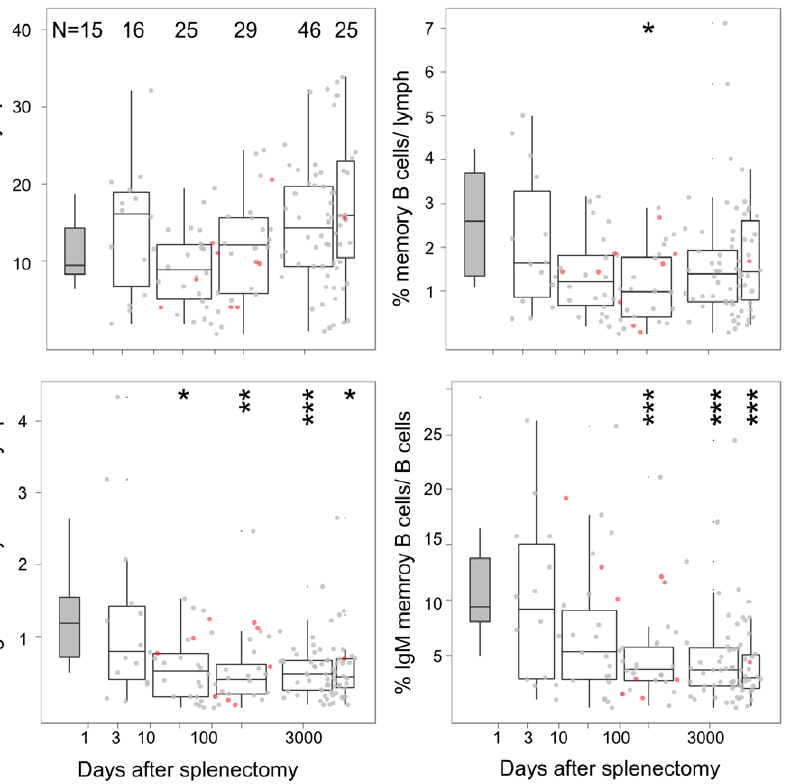
Figure 4. Kinetics of changes in B cell subsets after splenectomy. The time in days post-splenectomy for registry patients was determined from date of splenectomy to date of sample collection and plotted against proportion of lymphocytes represented by B cell numbers (i), memory B cells (ii), and IgM memory B cells (iii) and IgM memory B cells as proportion of total B cells (iv). Data covering periods 1–10 days, 10–100 days, 100– 1000 days, 10000–100001 days and . 10000 days were pooled for analysis. Only the analysis at the first assessment for each patient is shown and repeat measures shown in red were excluded from statistical analysis. Box-plot show the median as the horizontal line in the middle of the box, 25% as the lower end of the box 75% as the upper end and whiskers show the range. Outliers are omitted from the box-plots. The grey box-plot represents the normal reference range for the assay. Bonferroni corrected p values determined by Wilcoxon non-parametric statistic * , 0.05, ** , 0.001, *** , 0.0001 for comparisons to normal controls.